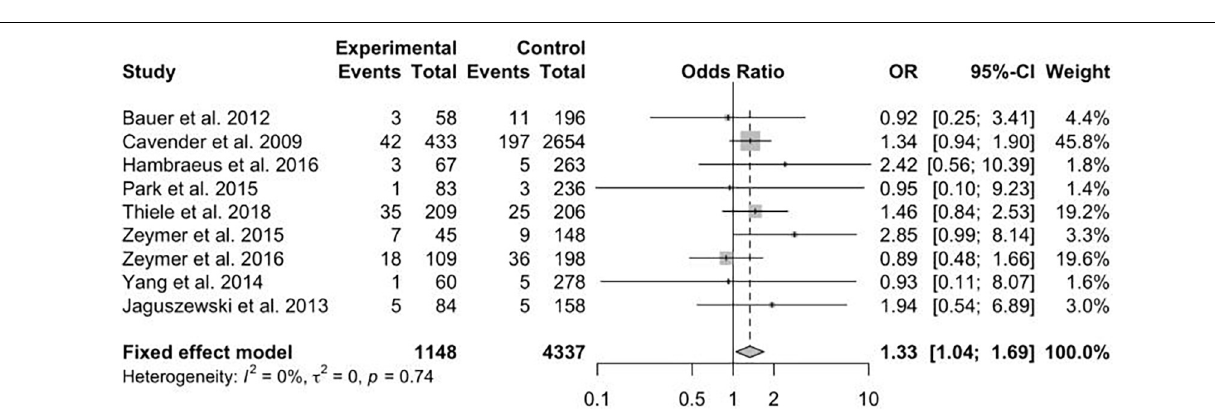
FIGURE 7 | Renal failure with multivessel (MV) vs. culprit vessel-only (CO) percutaneous coronary intervention (PCI) in patients with ST-segment elevation myocardial infarction (STEMI) complicated by cardiogenic shock